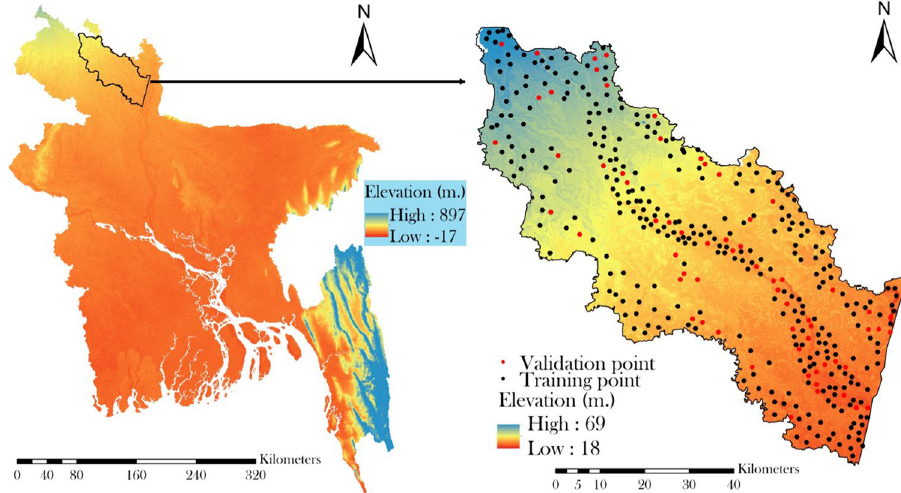
Fig. 1 The location of the study